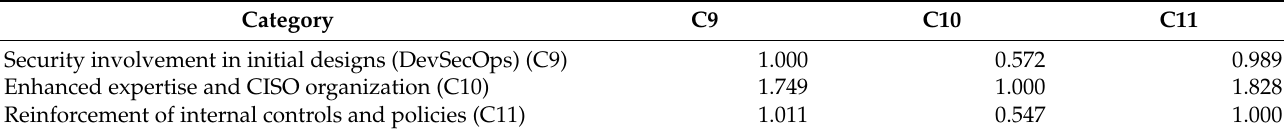
Table 12. Consolidated decision matrix for D3 sub-criteria.